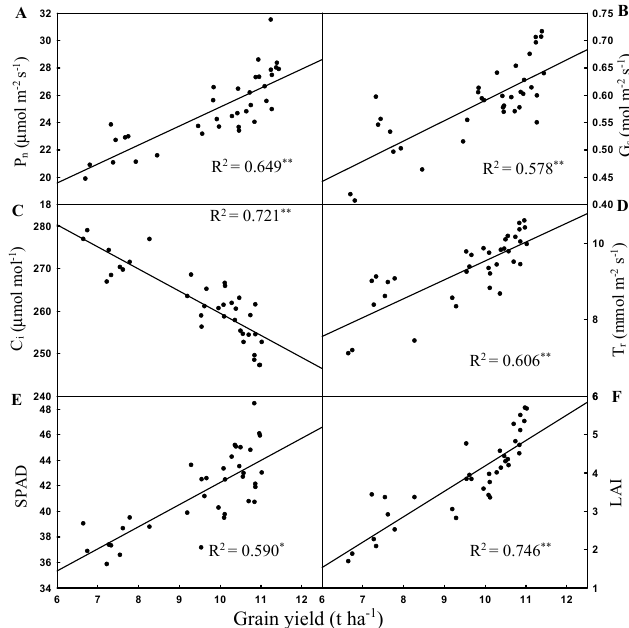
Figure 5. Relationships of grain yield to the Pn ( A ), Gs ( B ), Ci ( C ), Tr ( D ), SPAD ( E ), and LAI ( F ) in rice. * and ** represent significant correlations at p < 0.05 and p ≤ 0.01, respectively. Pn: net photosynthetic rate; Gs: stomatal conductance; Ci: intercellular CO 2 concentration; Tr: transpiration rate; LAI: leaf area index.